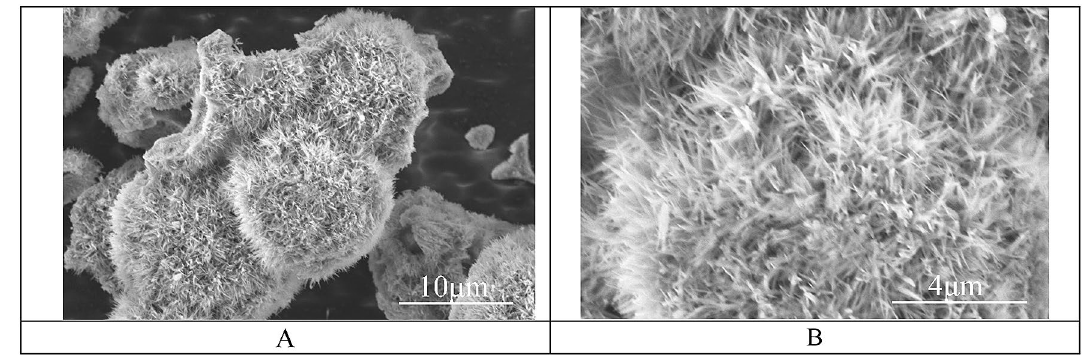
Figure 1. SEM images of the urchin-like Al 2 O 3 particles, synthesized according to the protocol, supplied in Ref. 28 . ( A ) Scale bar is 10 μm. ( B ) Scale bar is 4